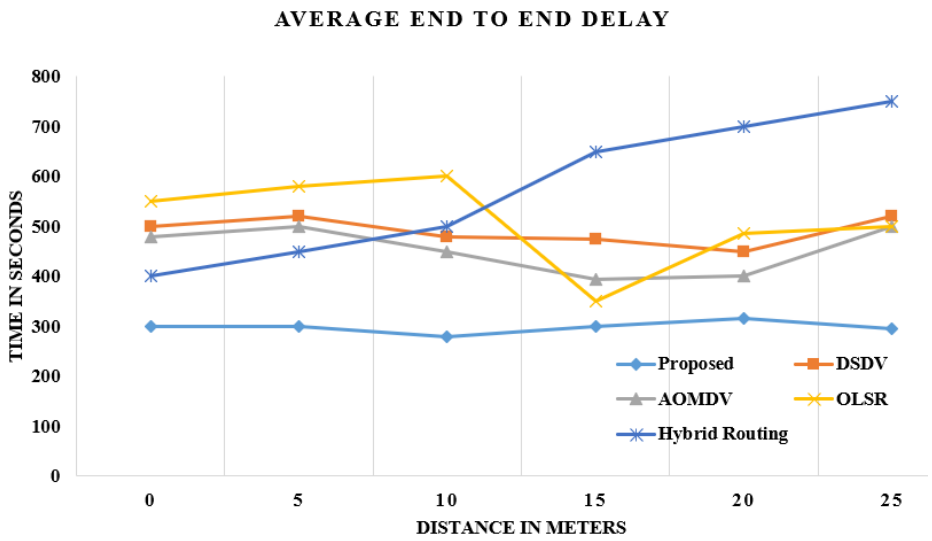
Figure 4. Comparison of delay in data